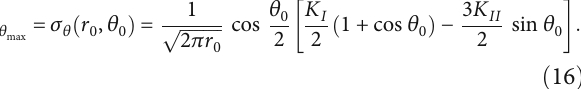
Figure 4: Formation of vertical tension